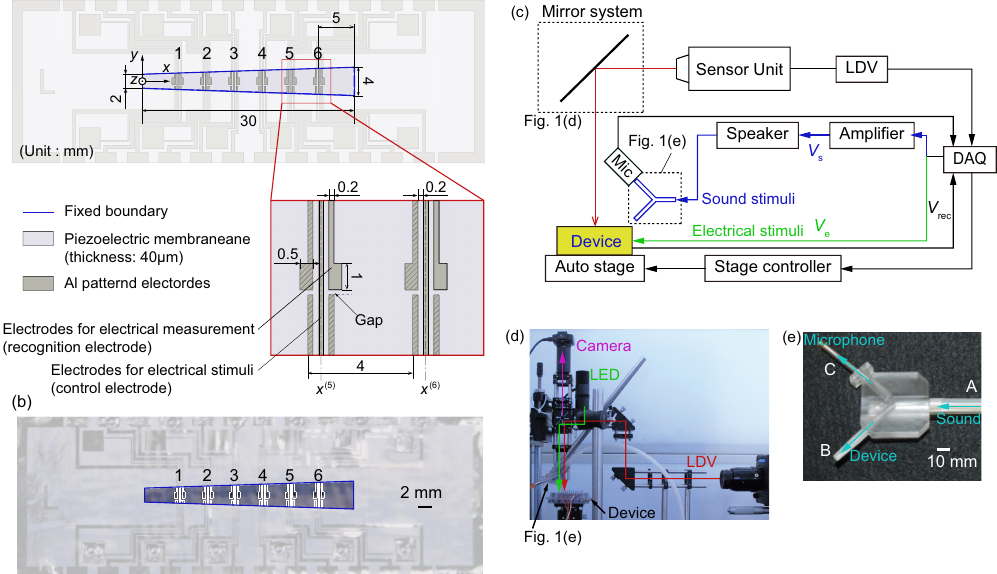
Figure 1. ( a ) Schematic and ( b ) photograph of the artificial cochlear epithelium fabricated in this paper. The patterned electrodes were fabricated on a polyvinylidene difluoride (PVDF) piezoelectric membrane with thickness of 40 µm; ( c ) Overview of the experimental setup. The multichannel analog output module in the data acquisition (DAQ) system was used to apply the sound and electrical stimuli with a desired phase difference. The DAQ system was also used to analyze the electrical output from the device and the results of laser Doppler vibrometer (LDV) measurement. These analyzed data were used in feedback control; ( d ) Details of the mirror system in panel (c) to observe the exact position